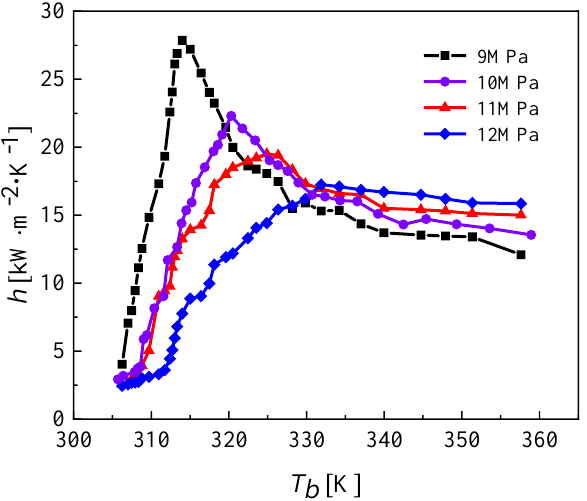
Figure 9. Grid independence.